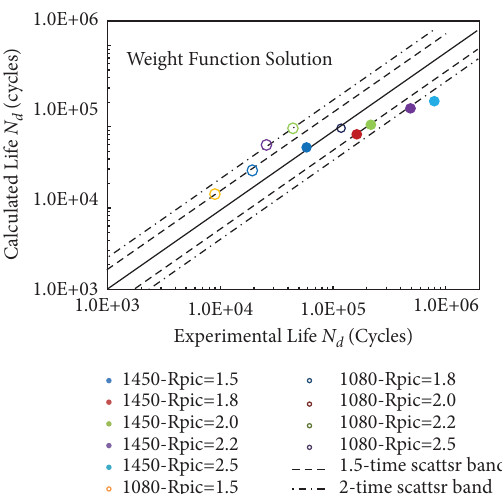
Figure 10: Comparison between experimental data and fatigue life estimated by Wu’s